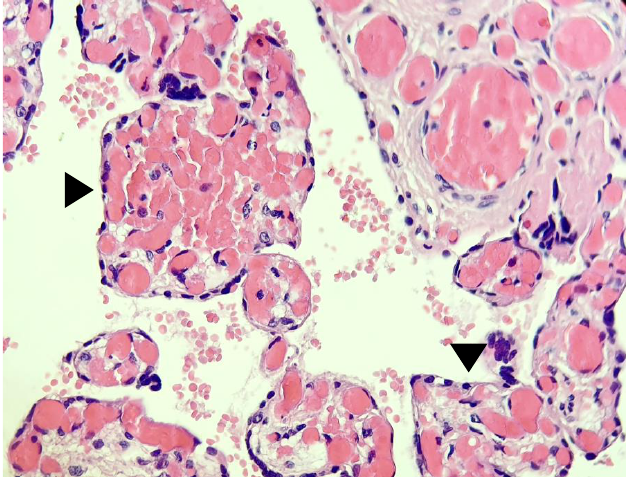
Figure 2. Detailed image showing >10 capillaries per terminal chorionic villus (black arrowhead) (20×).